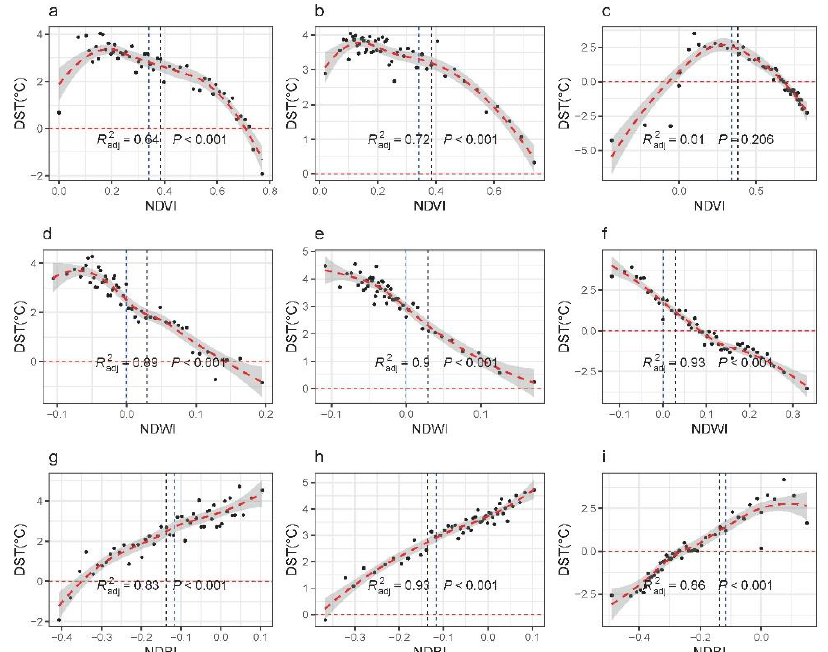
Figure 9. Single-factor scatter plots and fitting curves of DST to three surface biophysical indicators. Subgraphs ( a , d , g ) are for the group of functions for A, G and R; ( b , e , h ) are for the group of functions for B, M, S and W; ( c , f , i ) are for Non-construction areas. The vertical blue dotted line is the median value and the black one is the mean value of the corresponding independent variables; the horizontal red dotted line is the zero value of DST.